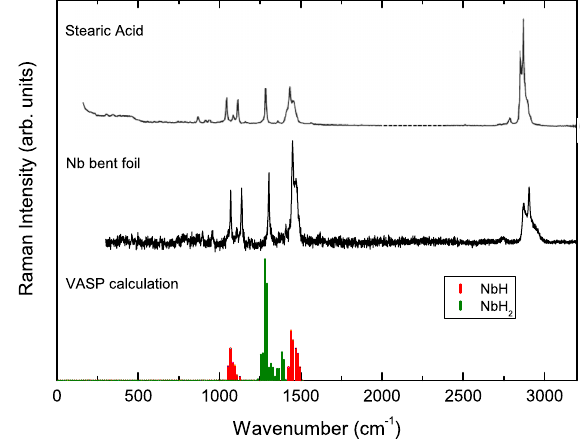
modes.FIG. 4. Raman spectra inside pits or rough spots on six differ- ent hot spot samples. The dark spot on the inset shows the optical image of a pit. For comparison the data from a recrystallized Nb foil (pit and cold-worked region) are shown along with the typical spectrum from a smooth region. Red and green lines correspond to the partial DOS of the entire optical branch for NbH and NbH 2 , respectively.